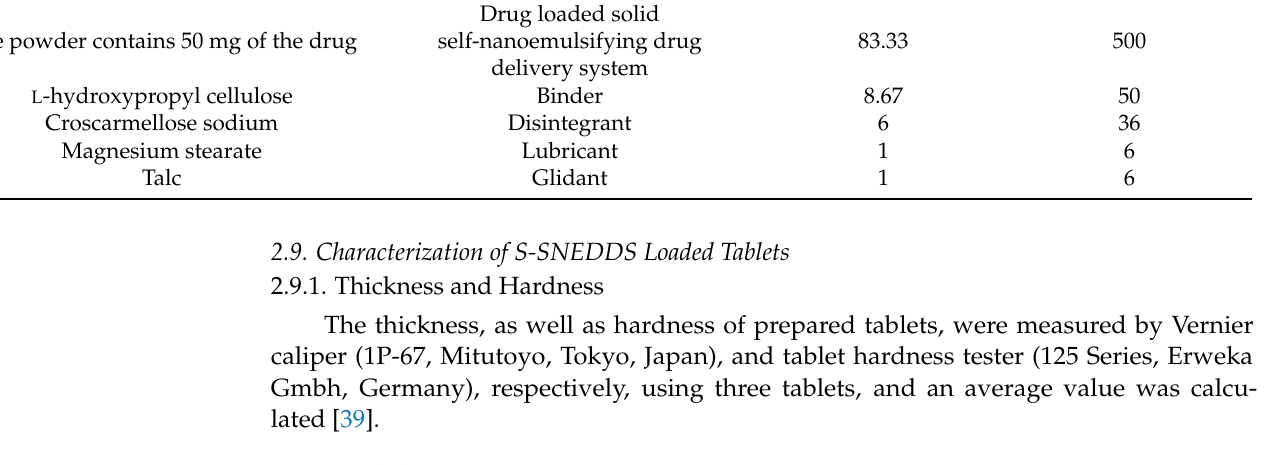
Table 2. Composition of the tablet preparation of solid self-nanoemulsifying drug delivery system.